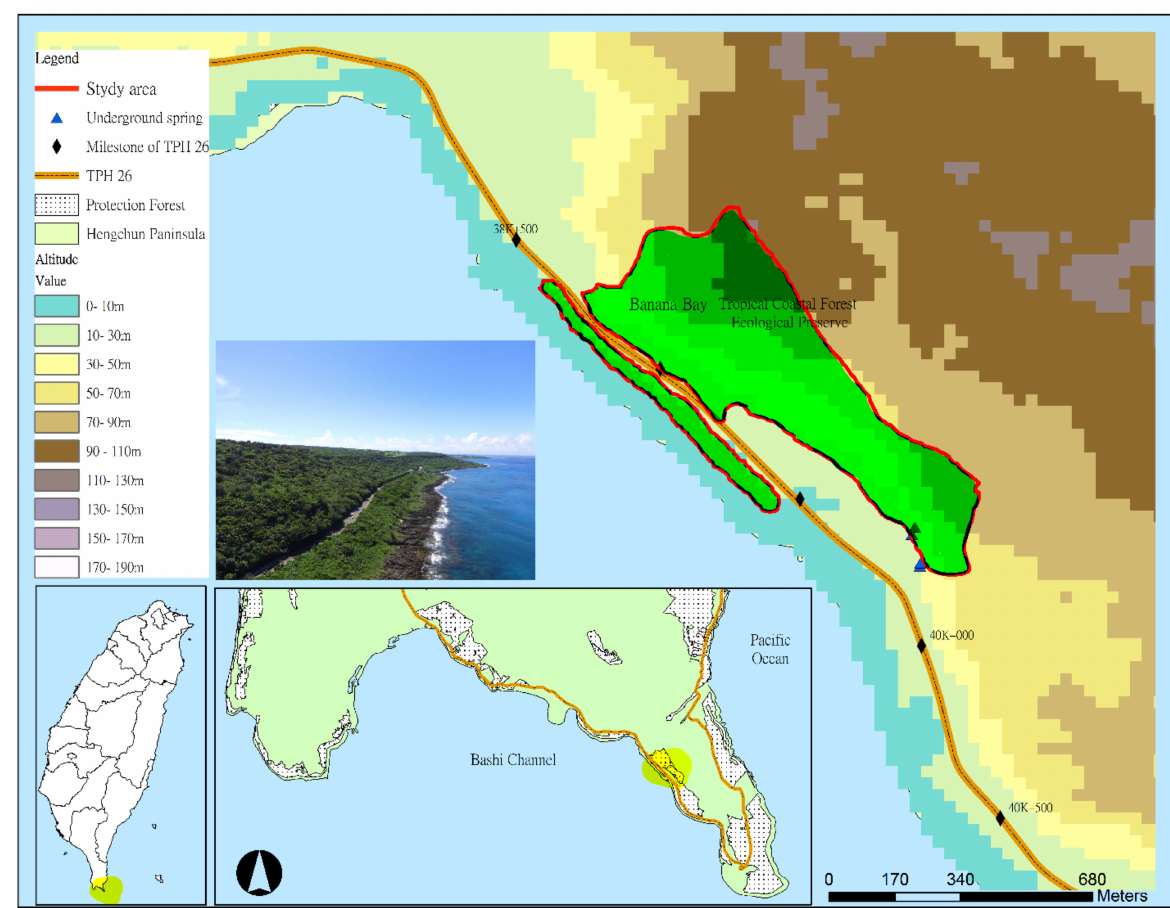
Figure 2. The study